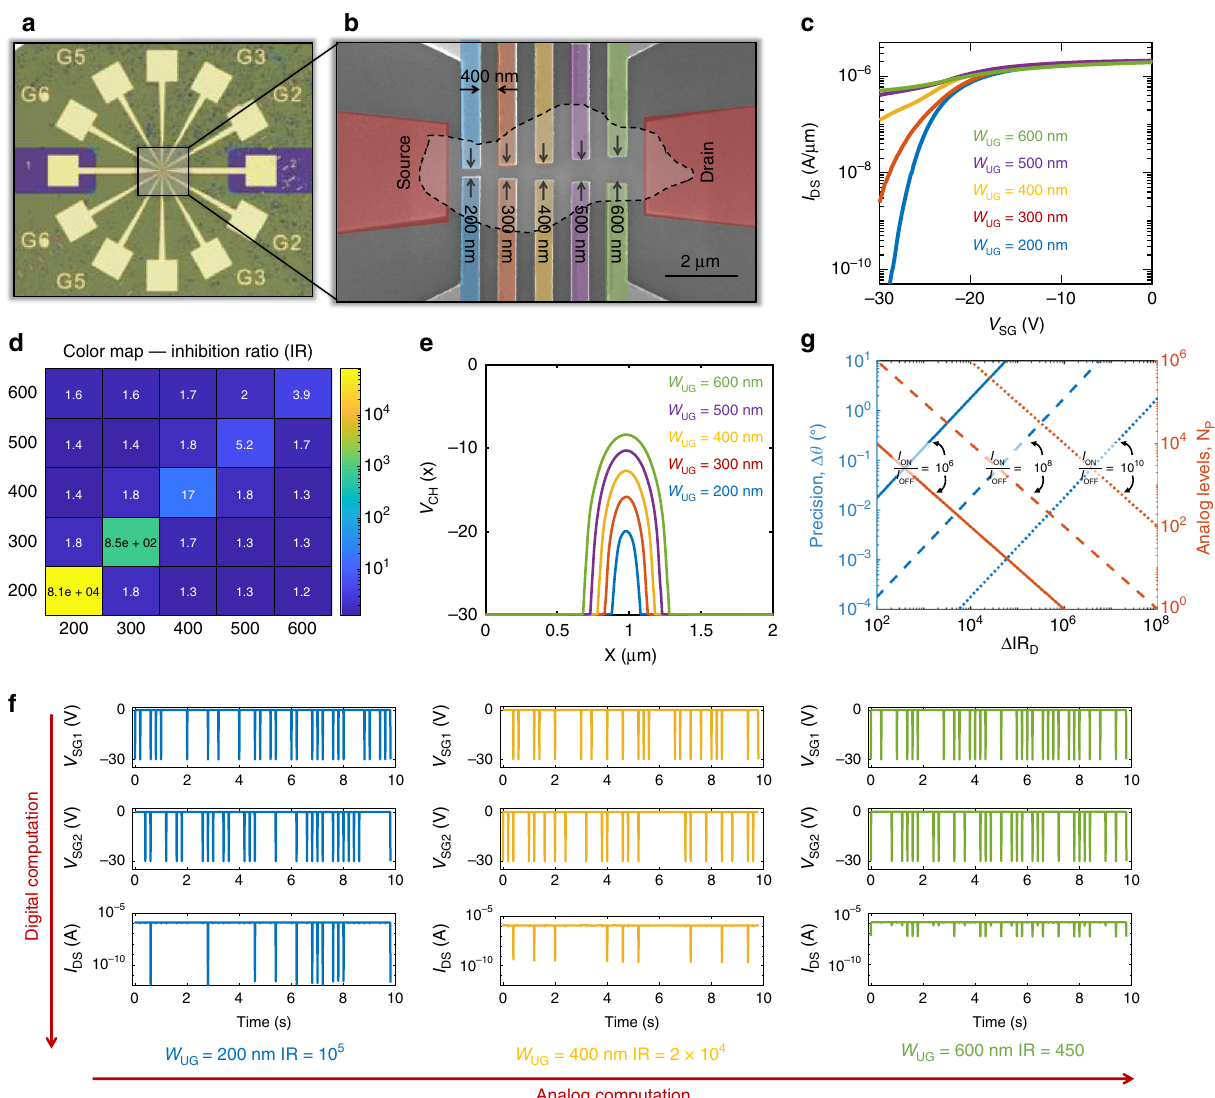
Fig. 3 Construction of neural auditory computational map. a Optical image and ( b ) zoomed in scanning electron microscope (SEM) image (false colored) of a biomimetic device for imitating the neural computational map inside the auditory cortex of barn owl. The device consists of multiple split-gates distributed along the length of the semiconducting MoS 2 channel which is connected to the source and the drain metal contacts. These split-gates have constant lateral spacing of 400 nm and monotonically increasing vertical spacing from 200 nm to 600 nm. c Transfer characteristics of the device when each of the fi ve colored pairs of split-gates are concurrently swept from 0 V to − 30 V. d Color map of the inhibition ratio (IR) for all possible combinations of the split-gate pairs. IR is de fi ned as the ratio of current through the device corresponding to V SG = 0 V and V SG = − 30 V, concurrently applied to a given split-gate pair. IRs are signi fi cantly larger for split-gate pairs that are vertically aligned (diagonal elements in the color map). Within these vertically aligned pairs, the one with minimum split-gate spacing has the maximum IR and vice versa. e COMSOL simulation showing the 1D potential pro fi le across the channel width for different split-gate spacing for V SG = − 30 V applied to both split-gates. The magnitude of the potential in the ungated segment is much closer to the split-gate potential when the spacing is 200 nm compared to 600nm and follows a monotonic trend as a function of the split-gate spacing. f Output current from the device when random voltage spikes of magnitude − 30 V are applied to the two spilt gates corresponding to different spatial pairs. All pairs detect coincidence by suppressing the device current which is a digital operation, whereas, the device as a whole determines the location of coincidence through analog IR values. g Angular precision ( Δ θ ) and corresponding number of analog computation levels ( N P ) as a function of the minimum difference between the analog IR values corresponding to two consecutive split-gate pairs ( Δ IR D ) for different current ON/OFF ratio of the semiconducting channel. Clearly, the biomimetic audiomorphic device can be designed to offer orders of magnitude better precision than the barn